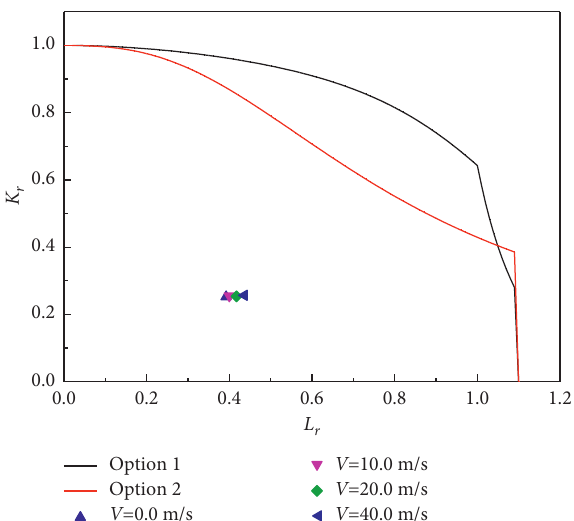
Figure 10: Effect of the top tension on the fracture performance of the